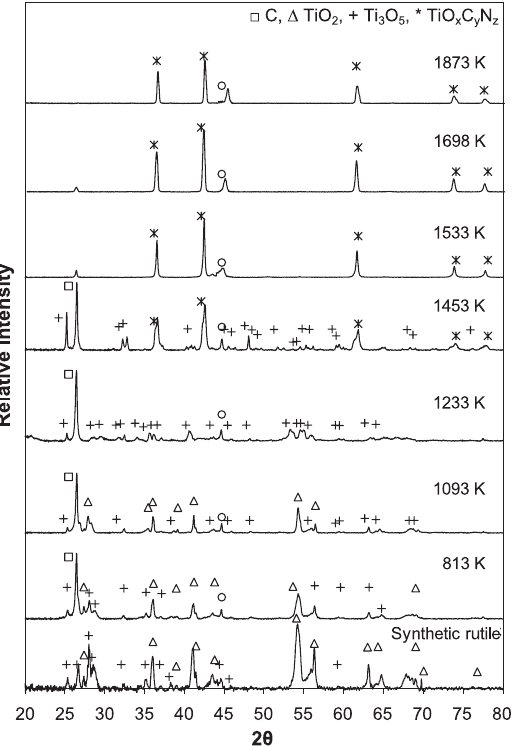
Fig. 5: XRD patterns of synthetic rutile in the progress of temperature programmed reduction in the H temperatures labeled in Figure 3.